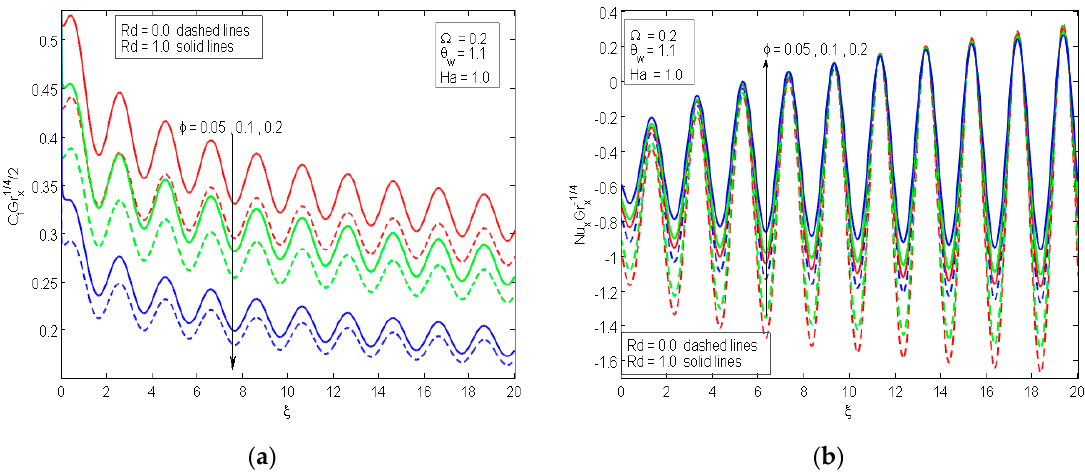
Figure 6. The effectiveness of φ and Rd on drag coefficient ( a ) and on Nusselt number ( b ). Figure 7a,b visualizes the conduct of temperature ratio parameter θ w on velocity f and temperature θ ( ξ , η ) distributions. It can be seen that both ( , ) f ξη′ and ( , ) θξη with the